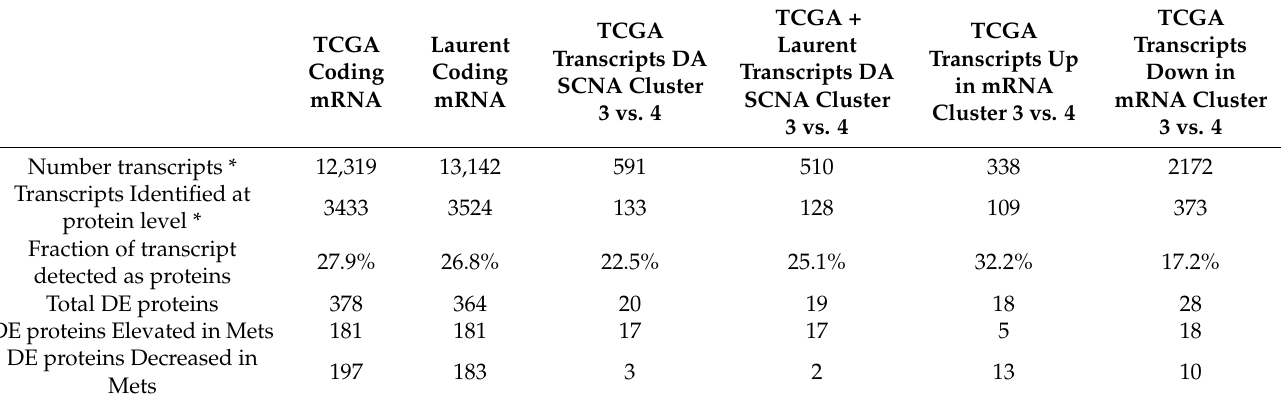
Table 4. Comparison of UM Proteomic Results with TCGA and Laurent Gene Expression